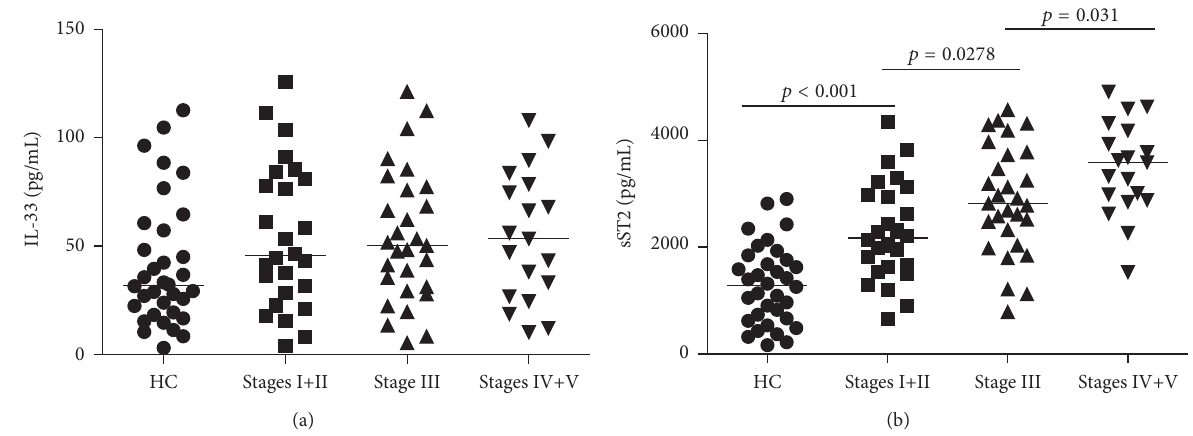
Figure 1: Analysis of sera IL-33 and sST2 in IgAN patients and HC. The levels of sera sST2 and IL-33 in IgAN patients and HCs were tested by ELISA. Data are expressed as the mean values of individual participants from two separate experiments; horizontal lines represent the median values of different groups. (a) Analysis of serum IL-33 levels revealed no obvious differences among different stage IgAN patients and healthy controls (HC) (all 𝑝 > 0.05 ). No significant difference in the levels of serum IL-33 was found among each stage of IgAN patients. (b) Serum sST2 levels were significantly higher in each stage of IgAN patients than in HC and furthermore tended to increase in parallel with the severity of the histopathological classification of IgAN ( 𝑟 = 0.443 , 𝑝 < 0.001